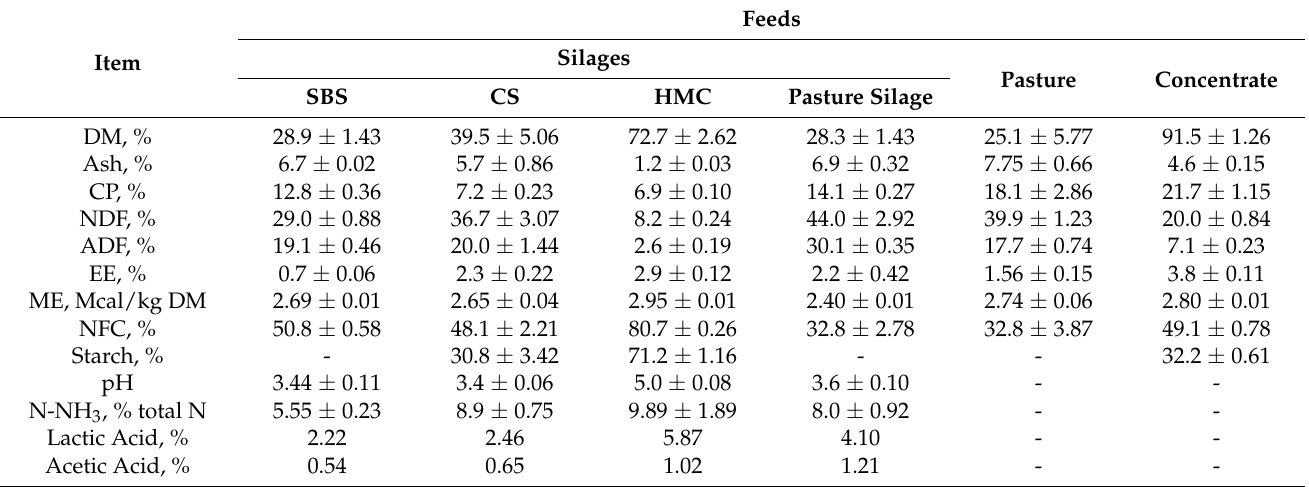
Table 2. Chemical composition of feeds offered to grazing dairy cows during the